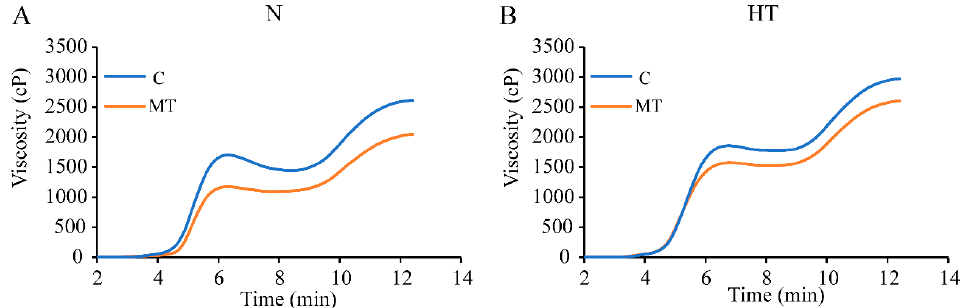
Figure 5. Effects of melatonin treatment on the pasting properties of NPB grown at different tem- peratures. ( A ) and ( B ) RVA analysis of NPB treated with exogenous substances under normal and high temperature. The data presented in the figure are repeated through three independent experiments. “N” and “HT” indicate normal and high temperature conditions. “C” and “MT” indicate H 2 O and melatonin treatment, respectively.